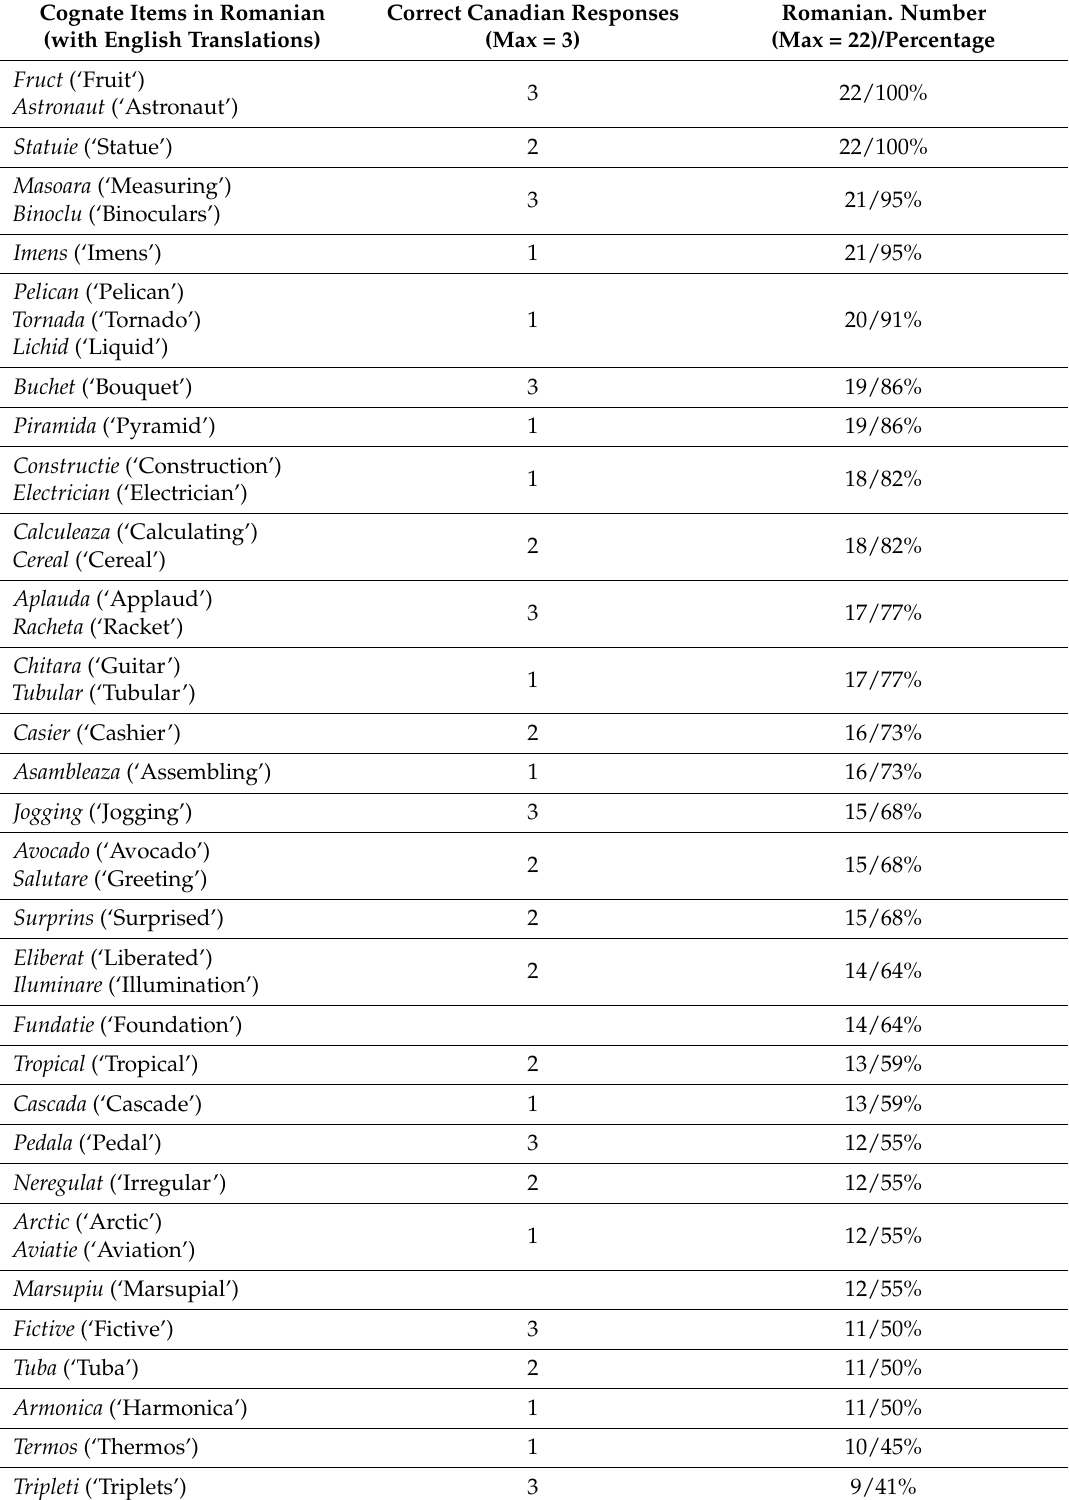
Table A3. Romanian-English